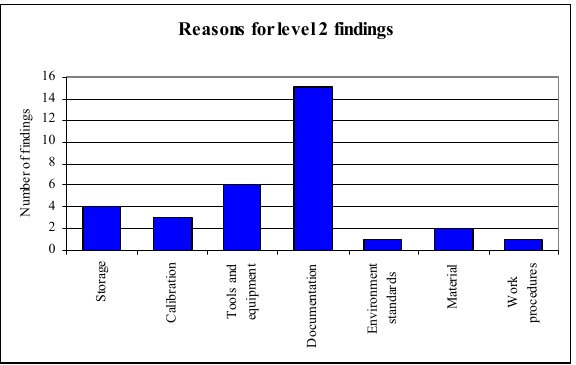
Fig 6 . The reasons for level 2 findings in organization YYY